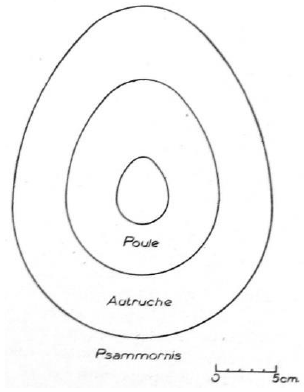
Figure 4. Outline reconstruction of a Psammornis egg by Monod on the basis of Schönwetter’s size estimates, with outlines of the eggs of an ostich and a hen for comparison. After Monod [51]. The specimens from Mauritania, like those from the Chebket Safra, are of especial importance because they were found in situ in a stratigraphic context, and therefore, provide evidence about the geological age of Psammornis. As noted by Tessier et al. [53], Ortlieb [55] and Hébrard [56], they occur in the Aguerguer sandstones, attributed to the Aguerguerian stage. A section of one of the localities was published by Hébrard [56] (Figure 5). As noted by Hébrard et al., [57], the Aguerguerian is, in fact, a regressive facies of the Middle Pleistocene Aioujian stage, and the clayey sandstones containing helicid gastropods and Psammornis correspond to paleosols.